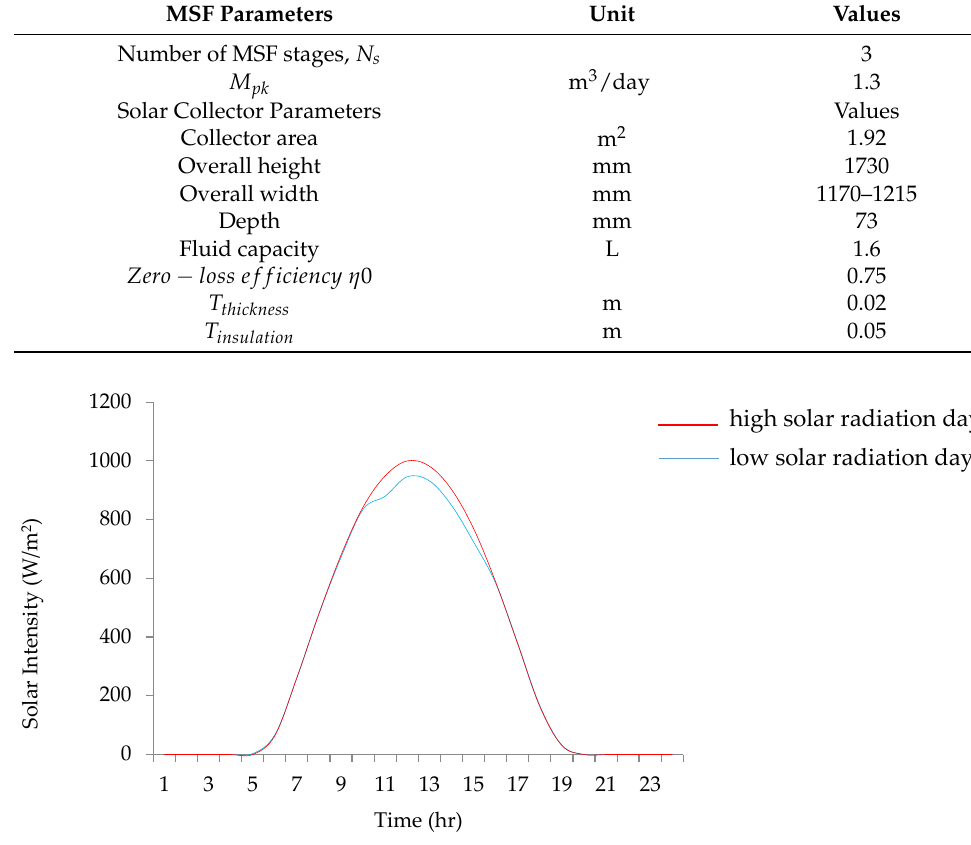
Figure 3. Hourly variations of solar radiation in September.